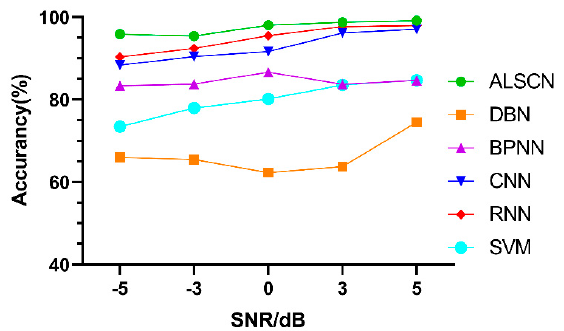
Figure 18. Test accuracy of different models under different SNR on MFPT. Table 10. The accuracy of different models with different SNR value on MFPT.